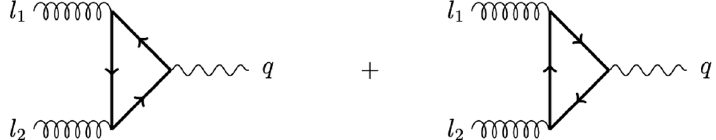
Figure 5 . The VVA triangle diagrams appearing as subgraphs in the heavy-mass expansion of (cid:12)gure